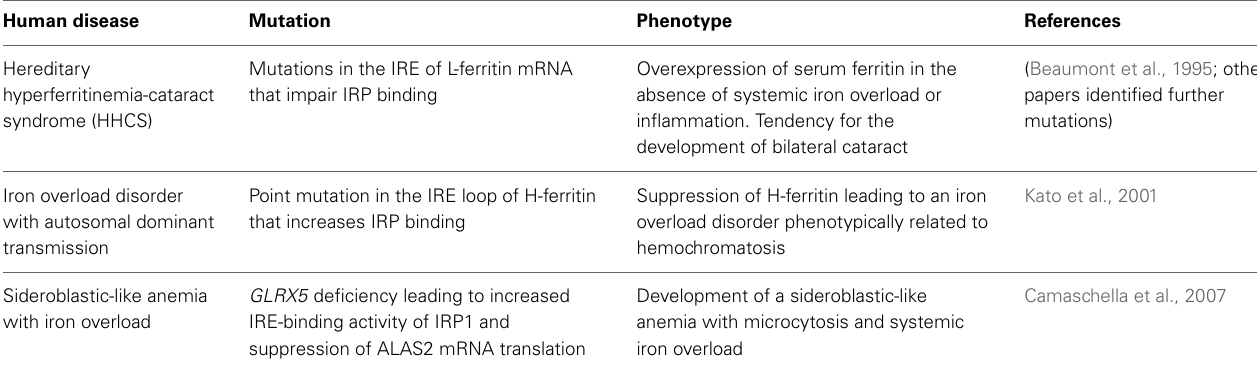
Table 1 | Human disorders that are causatively linked to defects in the IRE/IRP system.